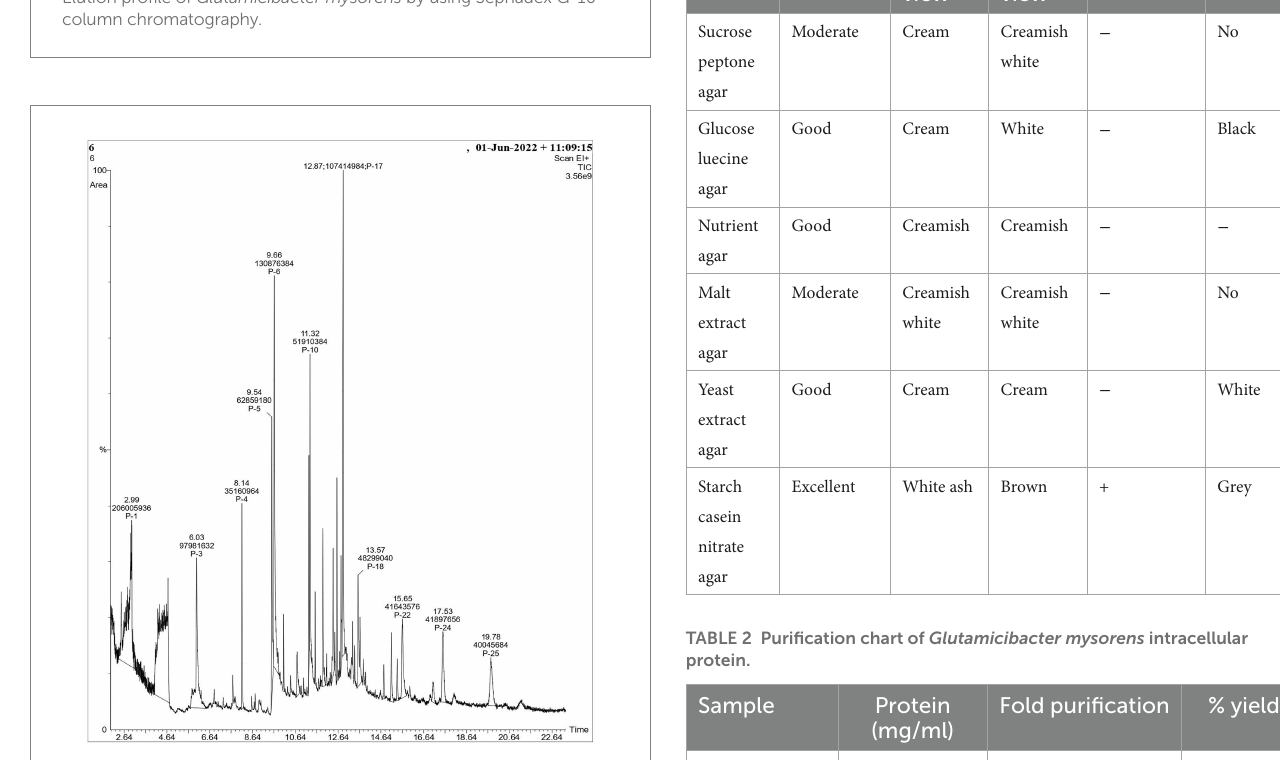
FIGURE 3 Elution profile of GCMS analysis for Glutamicibacter mysorens intracellular